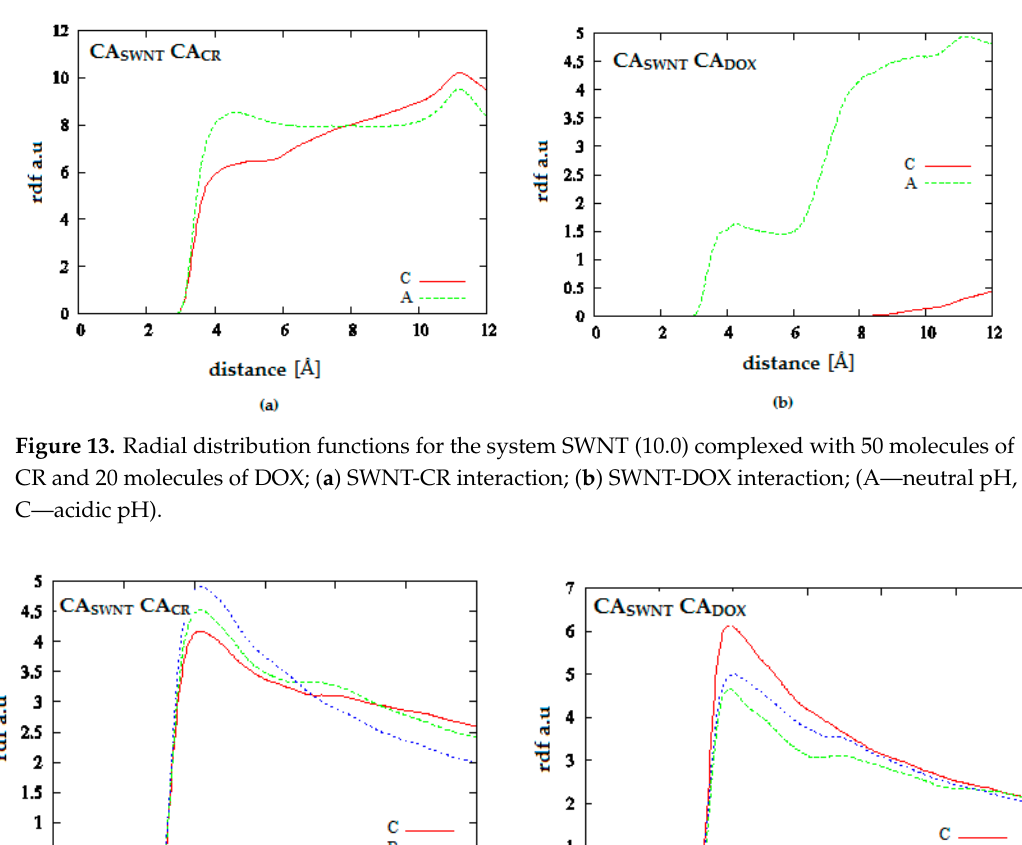
Figure 12. Radial distribution functions for the system SWNT (10.0) complexed with 20 molecules of CR and 10 molecules of DOX; ( a ) SWNT-CR interaction; ( b ) SWNT-DOX interaction; (A—neutral pH, B—medium pH, C—acidic pH).